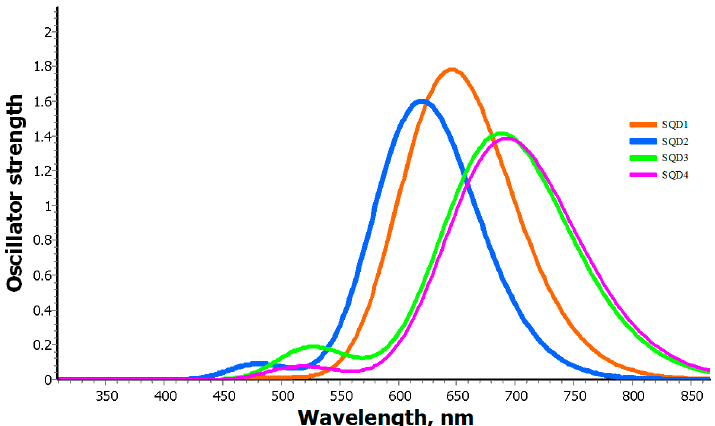
Figure 2. The UV-visible absorption spectra of SQD1–SQD4 calculated using PBE/6-311++G** level of theory in the gas phase.